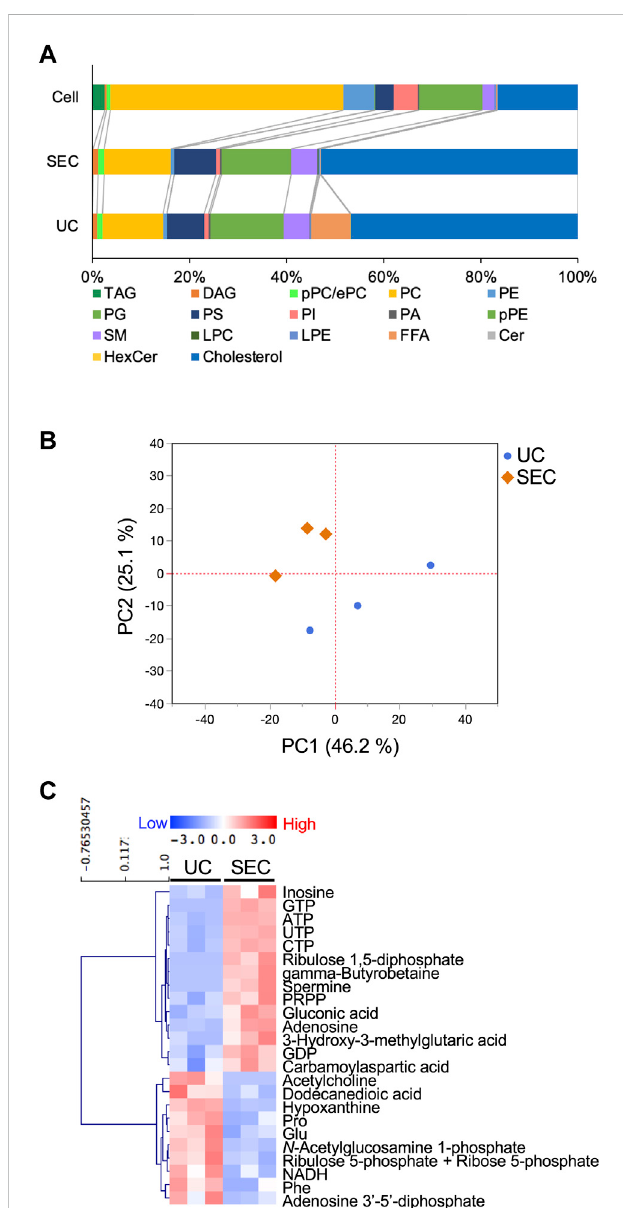
FIGURE 3 Effect of the collection method on the metabolite pro fi les in sEVs (A) Pie plots showing themol-based percentile ofeach lipid class incells andEVscollectedbySECandUC. (B) Principalcomponentanalysis(PCA) score plot of hydrophilic metabolites and lipids from UC (blue circles) and SEC (orange diamonds) samples. The contribution ratios were 46.2% and 25.1% for PC1 and PC2, respectively. Metabolites that were detected in over 50% of the samples were included in the analysis. Metabolite data from the non-cultured medium were subtracted and then normalized by particles measured by NanoSight. (C) Heatmap showing the metabolite pro fi les of sEVs that signi fi cantly changed metabolites between UC and SEC recovery systems. The p -value was calculated usingtheStudent ’ st-test, and p -value < .05wasconsidereda signi fi cant change. n = 3.